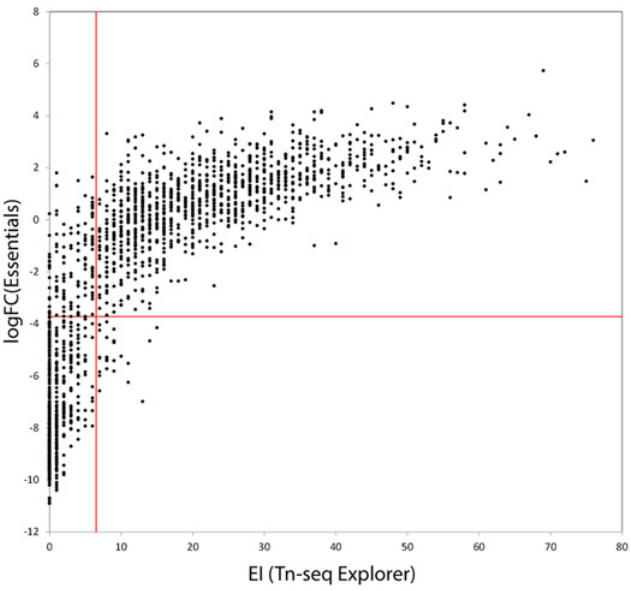
Fig 4. Comparison of EI values from Tn-seq Explorer and LogFC values from ESSENTIALS for the 1772 annotated genes in the M . maripaludis S2